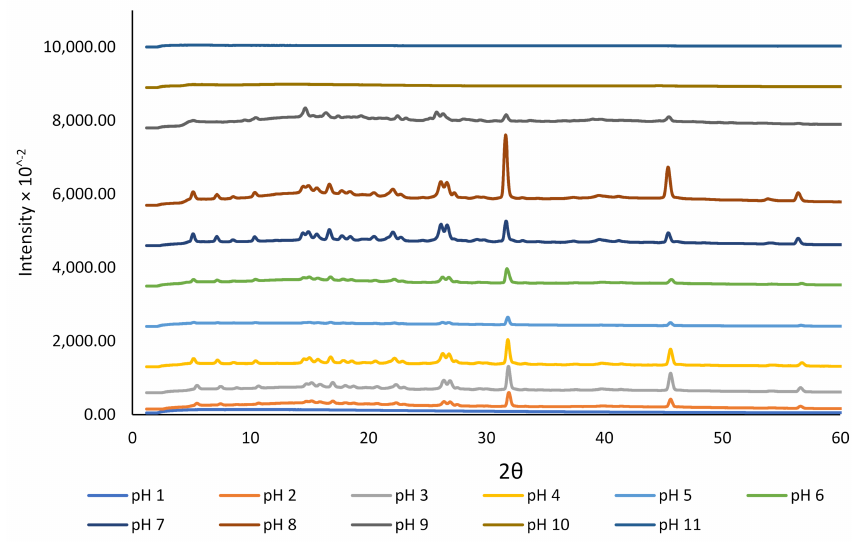
Figure 2. The effect of pH on the crystallinity of rutin encapsulated in NaCas (1%). The crystallinity results obtained for rutin at various pH conditions in the current study were confirmed using SEM (Figure 3). At pH 11, 10, and 9, rutin particles shared a common arrowhead-like morphology that was distributed throughout the specific micrographs. The crystals that formed at the pH close to the neutral pH were more granular and similar